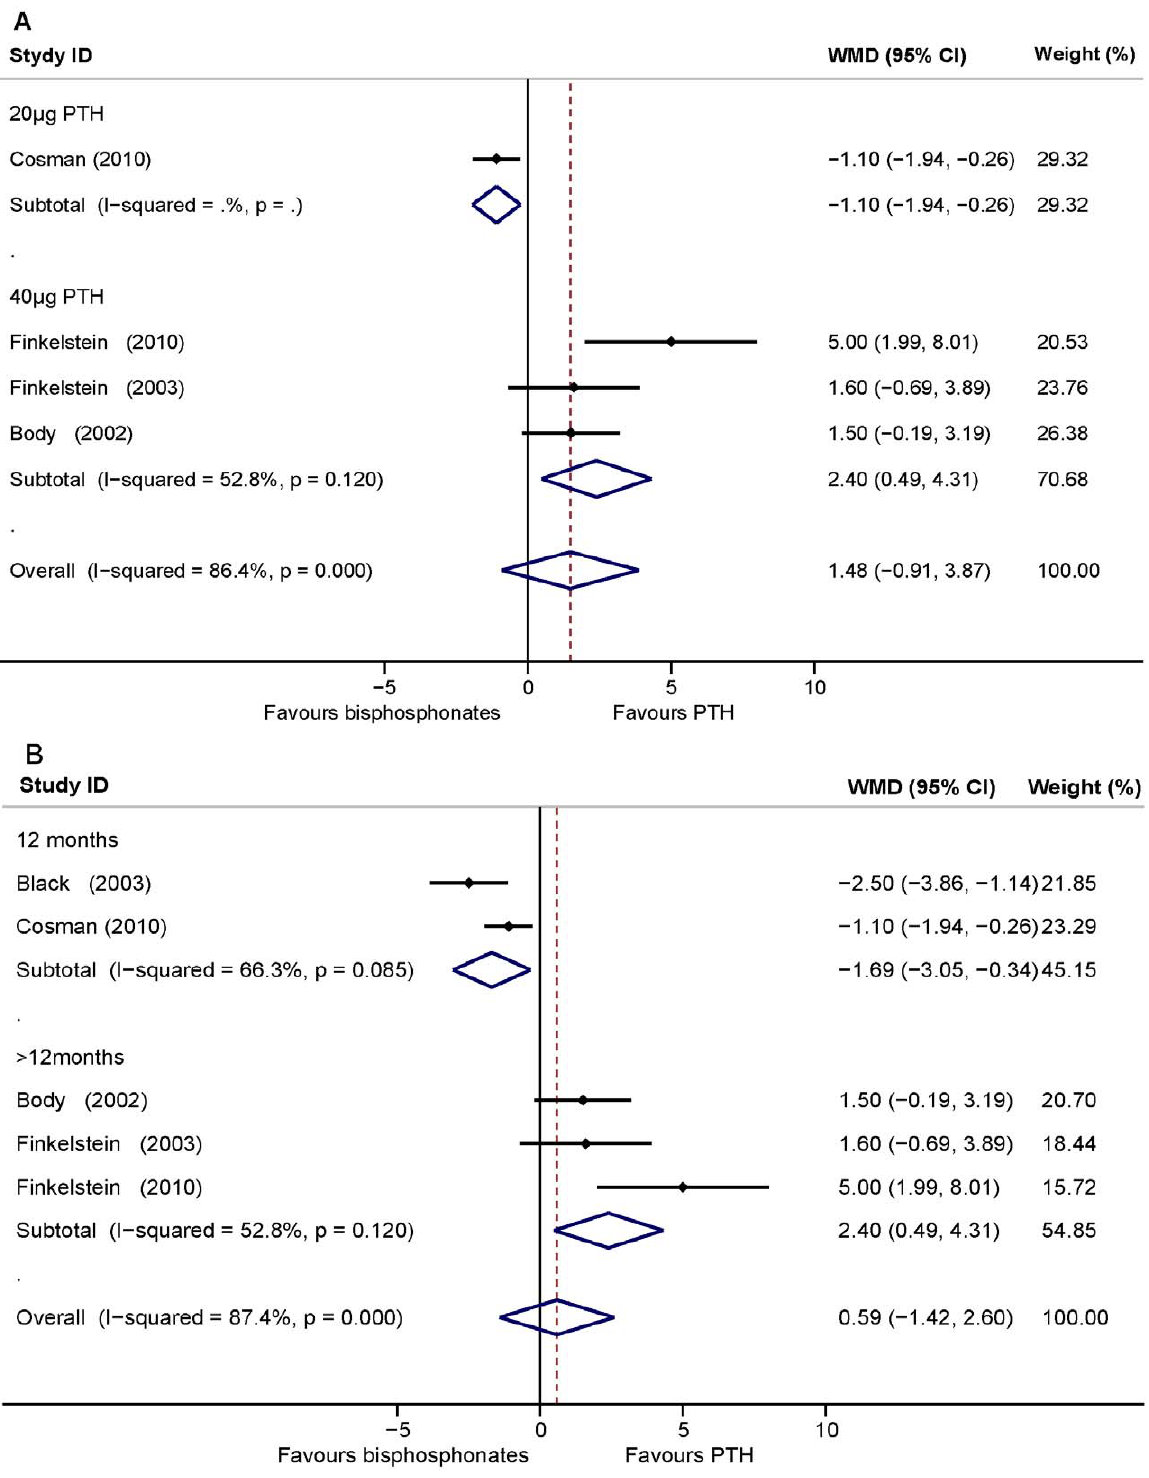
Figure 5. Assessment of the effects of PTH versus bisphosphonates on BMD of the total hip. A: Subgrouped analysis of the dosage of PTH (1–34) versus bisphosphonates treatment on total hip BMD. B: Subgrouped analysis of the duration of PTH (1–34) versus bisphosphonates treatment on total hip BMD.